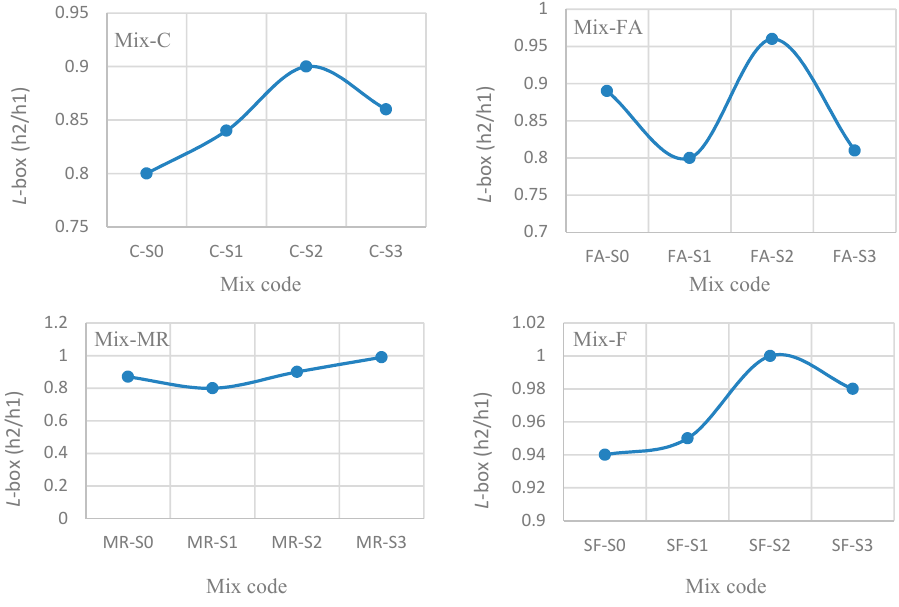
Figure 4. L -box results of all SFR‒SCC groups.